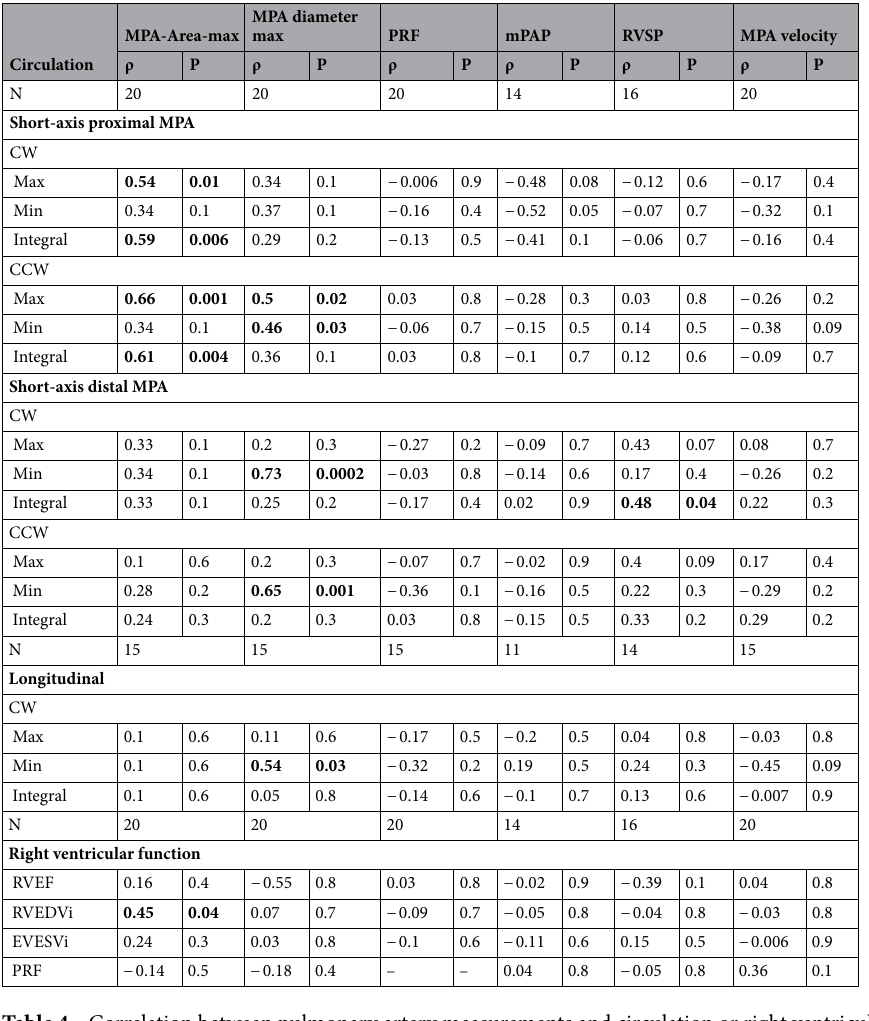
Table 4. Correlation between pulmonary artery measurements and circulation or right ventricular function. The area of the MPA was positively correlated with clockwise and counterclockwise circulation in the proximal MPA. The diameter of the MPA was positively correlated with counterclockwise circulation in the proximal MPA. The diameter of the MPA was positively correlated with clockwise and counterclockwise Min circulation in the short-axis distal MPA. The diameter of the MPA was positively correlated with the Min longitudinal circulation. P-value (P) from Spearman signed rank test. Boldface indicates statistical significance (p < 0.05). indexed for body surface area, ESVi end-systolic volume indexed for body surface area, CW clockwise, CCW counter